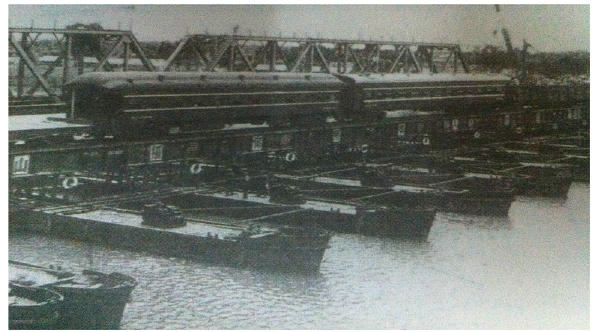
Fig. 19 Opening traffic of the 67-type railway pontoon bridges